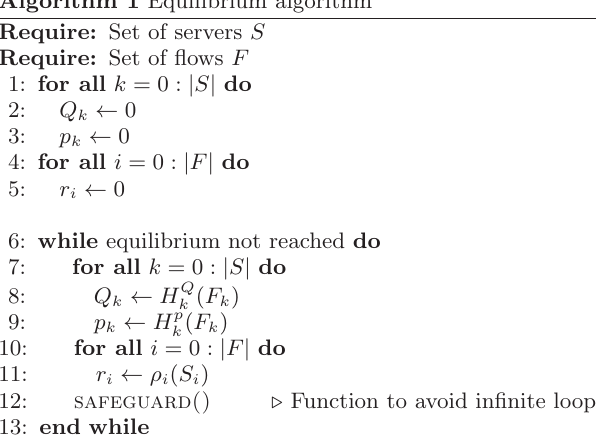
Algorithm 1 Equilibrium algorithm